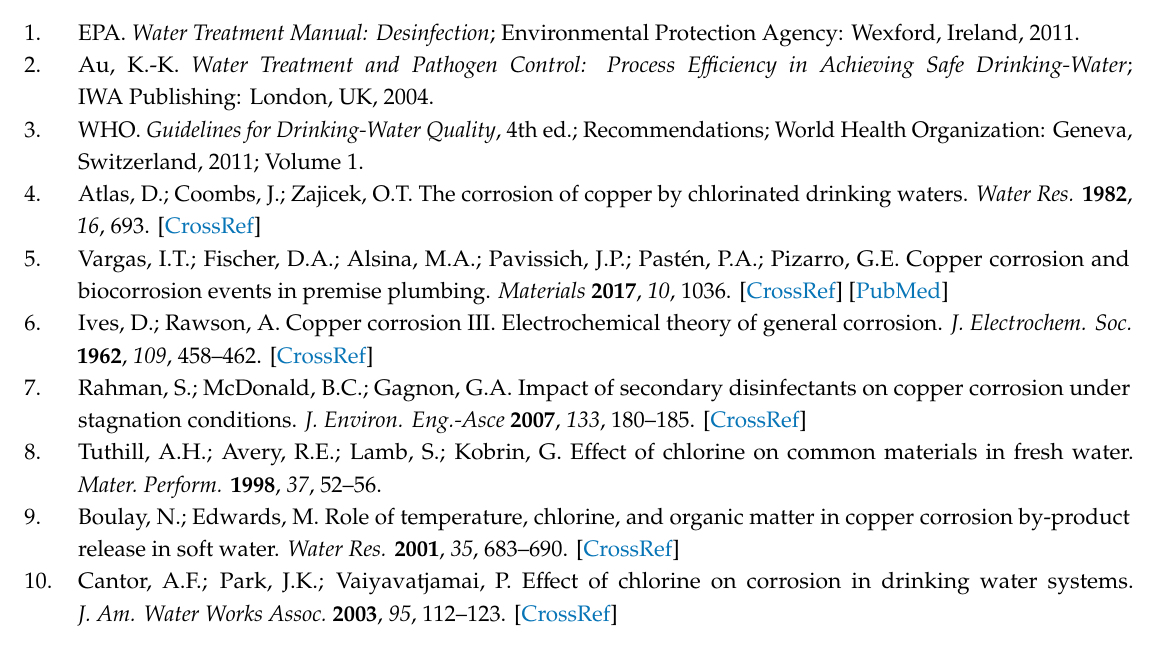
Figure S1: Copper release measurements in pipes with water at di ff erent chlorine concentration after 8 h of stagnation, Figure S2: Pipe tests conducted with di ff erent initial concentration of free chlorine, Figure S3: Scanning electron microscopy (SEM) images of new copper pipes in stagnant conditions with synthetic water (chlorine concentration of 4 mg / L, DIC of 80 mg as CaCO 3 , and pH 7.2), Figure S4: Pourbaix diagram of the corrosion by-products formed on the metallic surface of a copper-chlorine-carbonate system at 25 ◦ C (respect to standard hydrogen electrode,